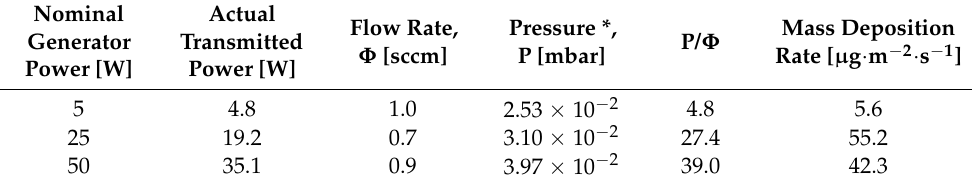
Table 1. Plasma Parameters used in this